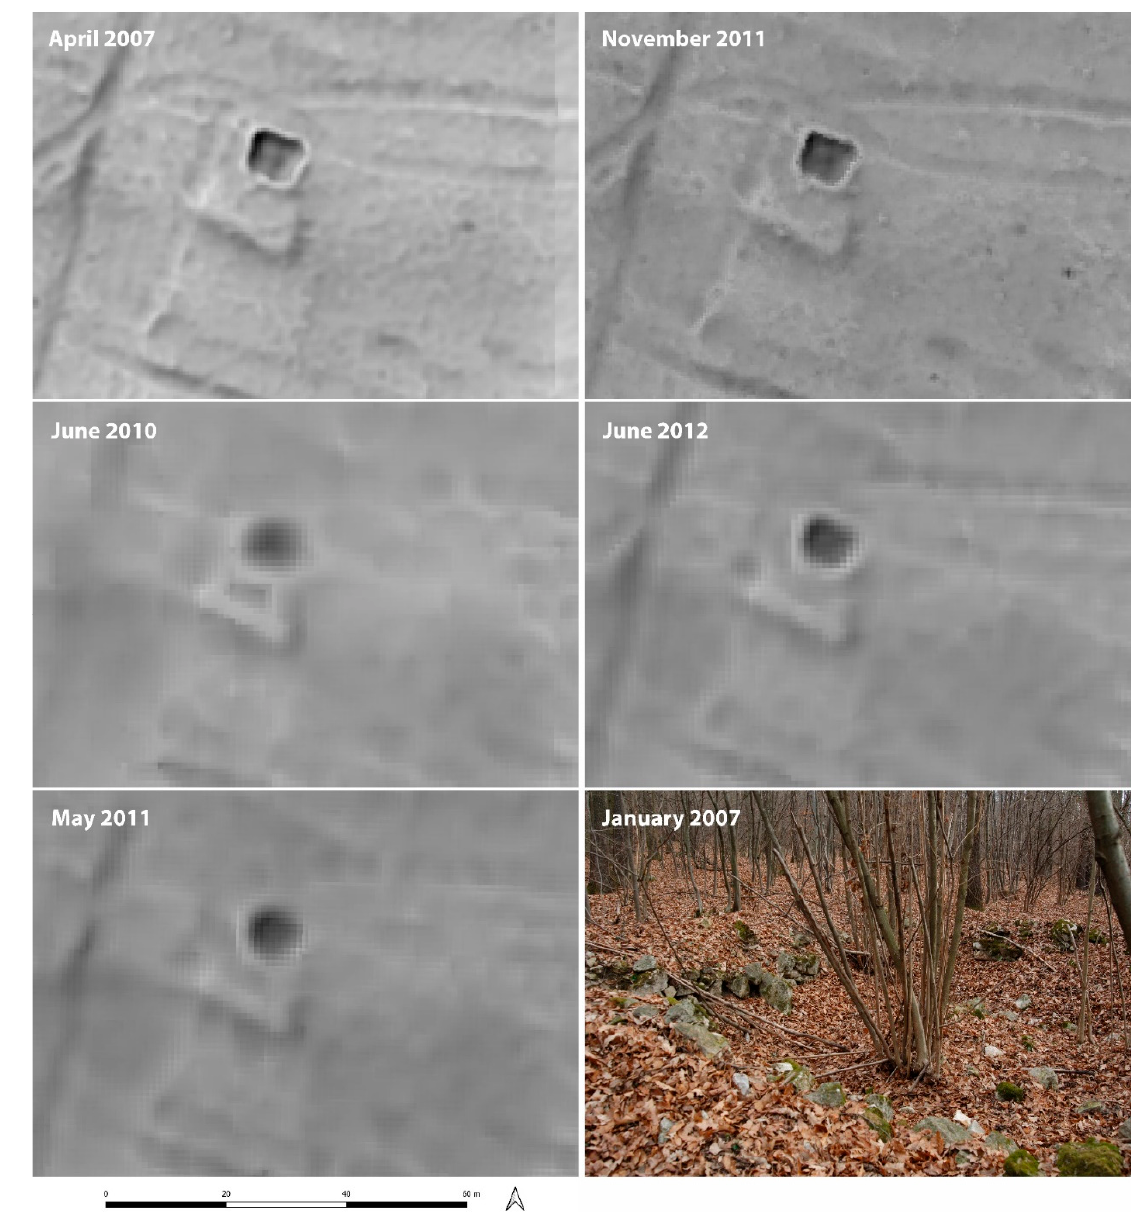
Figure 19. Sub-sample of Area 2 displaying the foundation of a hermit‘s cell on a small artificial terrace. All visualizations are a combination of positive openness (with colour gradient black to white, stretch to min–max, min. 1.41–max. 1.58) and hillshade. The photograph ( lower right image ) shows the area of the farm building from January 2007 (photograph by M. Doneus).